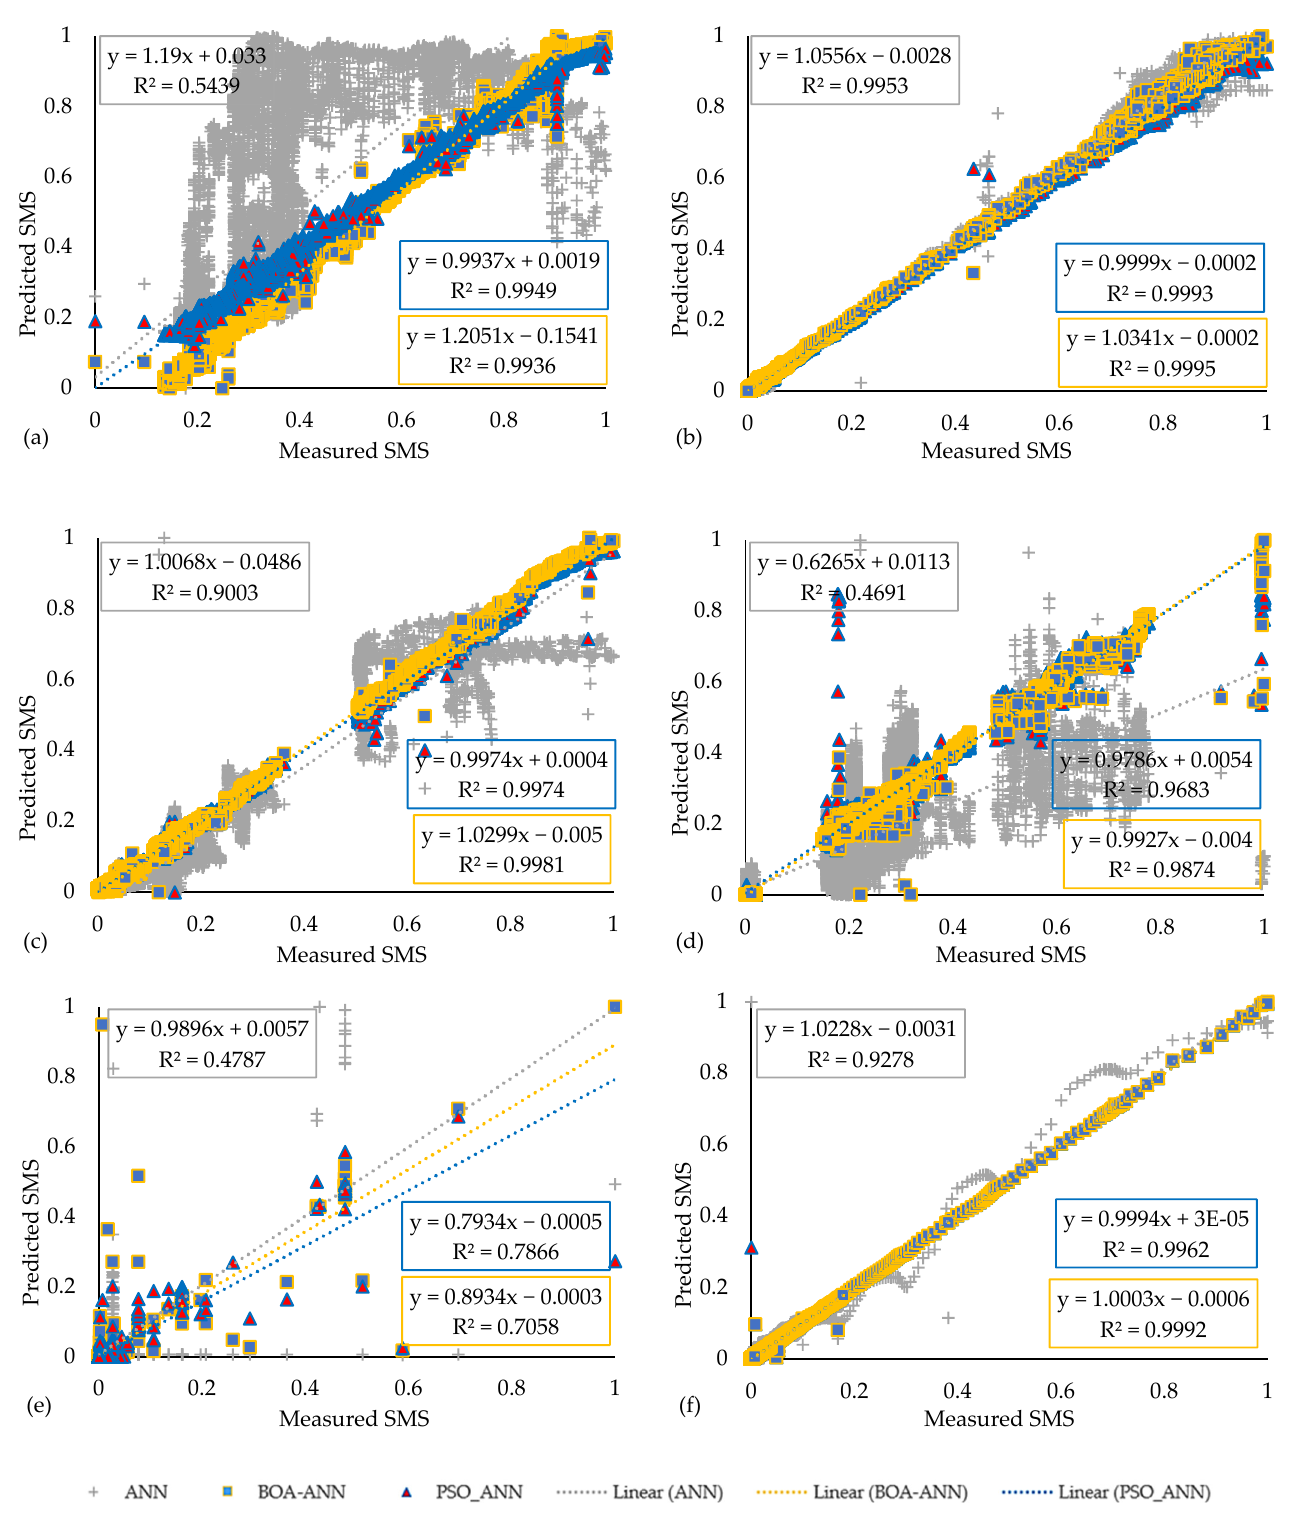
Figure 8. Predicted vs. measured SMS at 1.5 m depth overtime via ANN-BR model, PSO-ANN model, and BOA-ANN model along with the impact of the number of iterations on the predictive